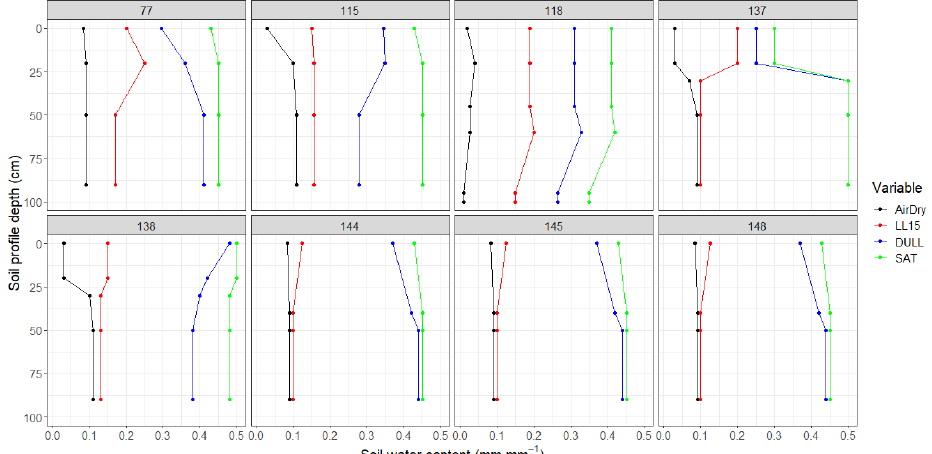
Figure 6. Soil moisture curves of selected APBs. Variables analyzed: soil air dry (AirDry, black line), 15 Bar (−1500 kPa) lower limit (LL15, red line), drained upper limit (DULL, blue line), and soil water saturation (SAT, green line).